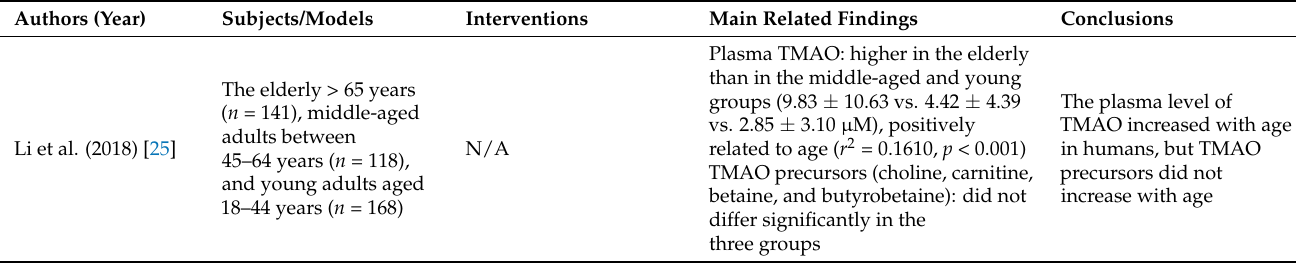
Table 1. Main studies of TMAO involved in healthy